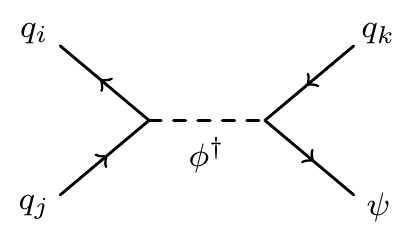
Figure 1 . The \mono- (cid:30) " simpli(cid:12)ed model that (cid:12)ts well the monojet excess in the CMS and ATLAS